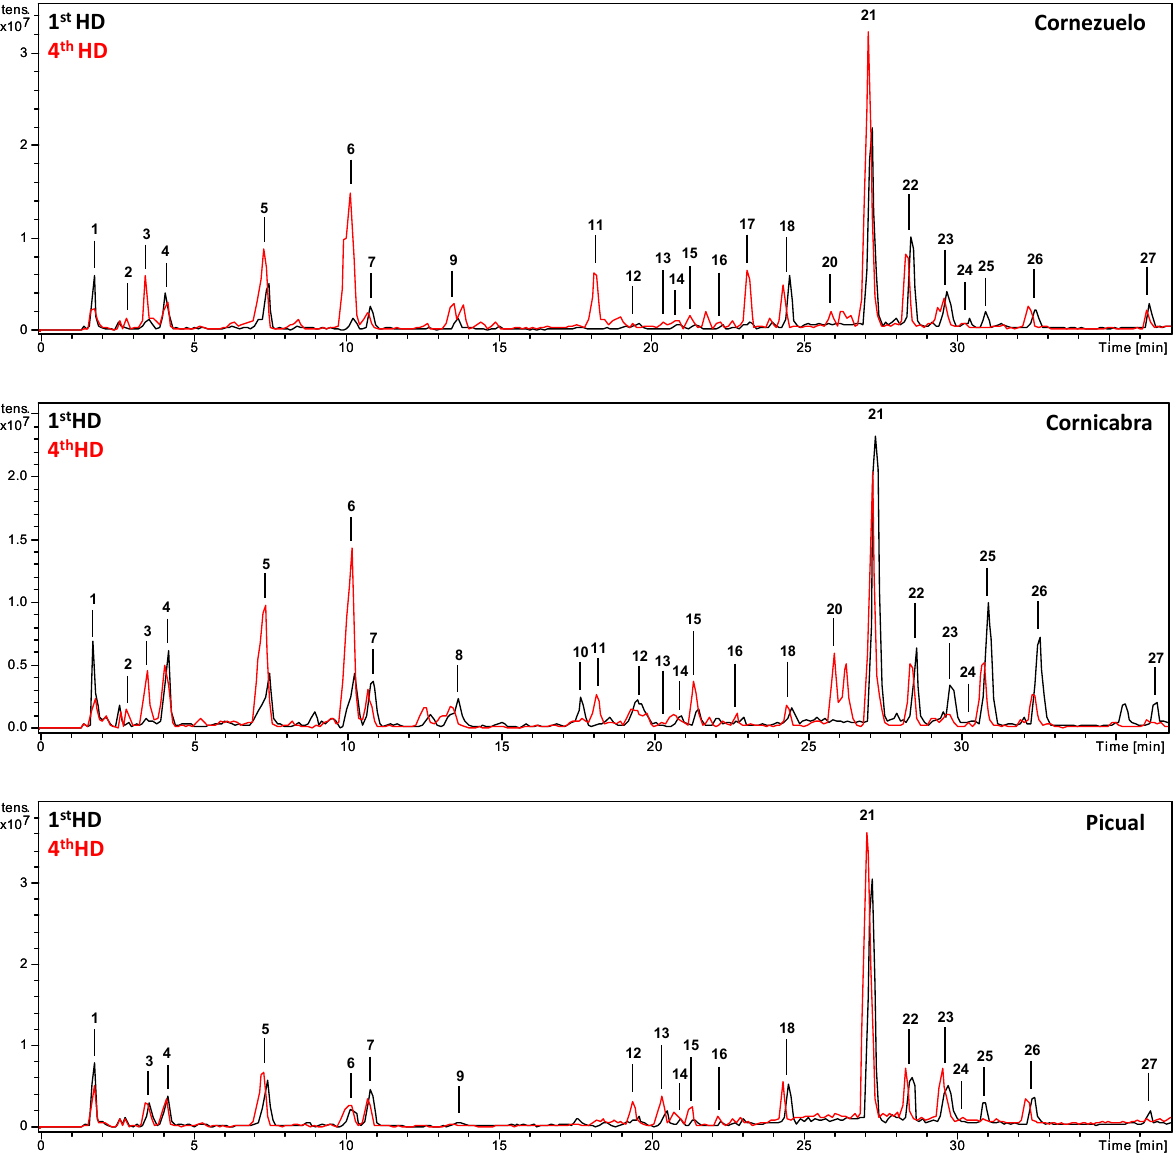
Figure 2. HPLC-ESI/MS n base peak chromatograms (BPC) of the extracts of Cornezuelo, Cornicabra and Picual olives in 1 st HD and 4 th HD (2018/2019 season).